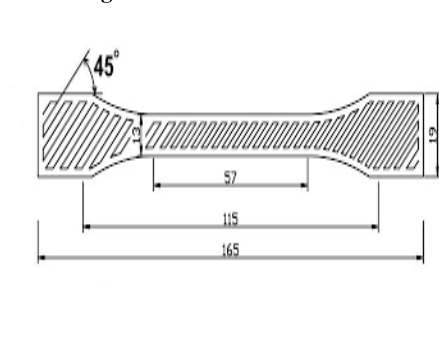
Fig . 2. Tensile test machine. Fig . 3. Tensile test specimens.